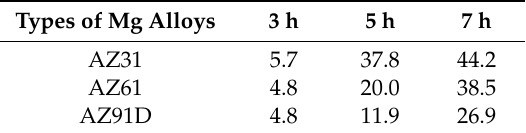
Figure 4. Cross sectional SEM and overlapped mapping images for Mg (red), Al (blue), and O (green) of film prepared at 423 K for 5 h on ( a , d ) AZ31, ( b , e ) AZ61, and ( c , f ) AZ91D. Table 2. Film thickness obtained from cross sectional SEM images of the films prepared at 423 K for different treatment times on AZ31, AZ61, and AZ91D Mg alloys (unit: µ